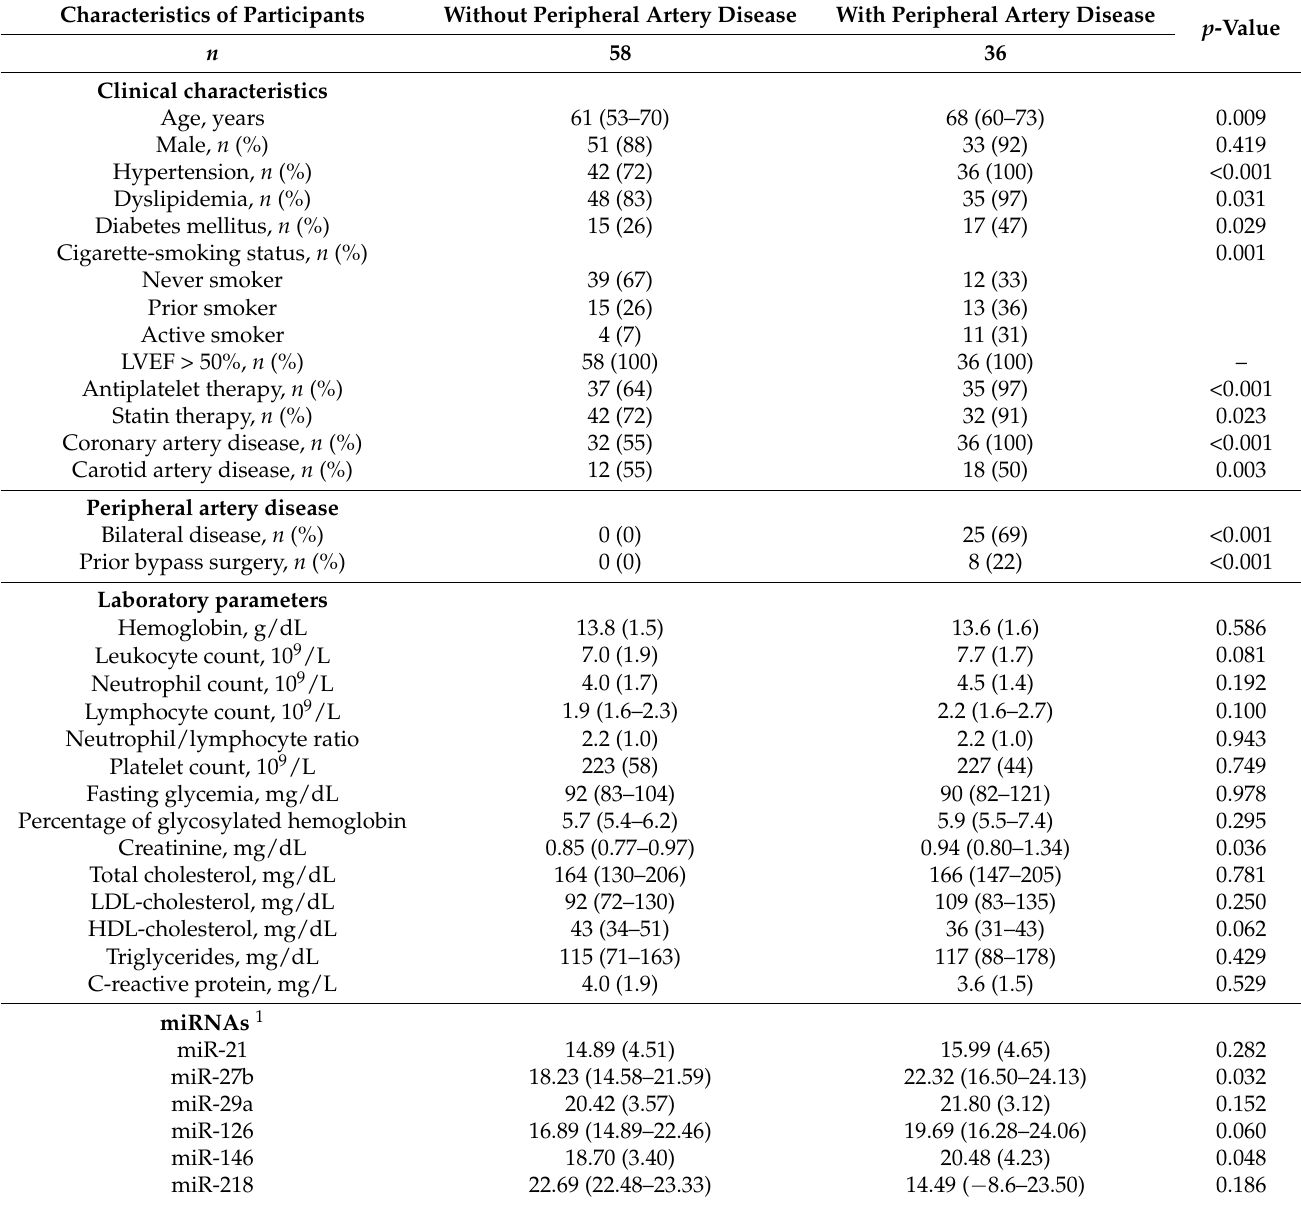
Table 1. Characteristics of participants without and with peripheral artery